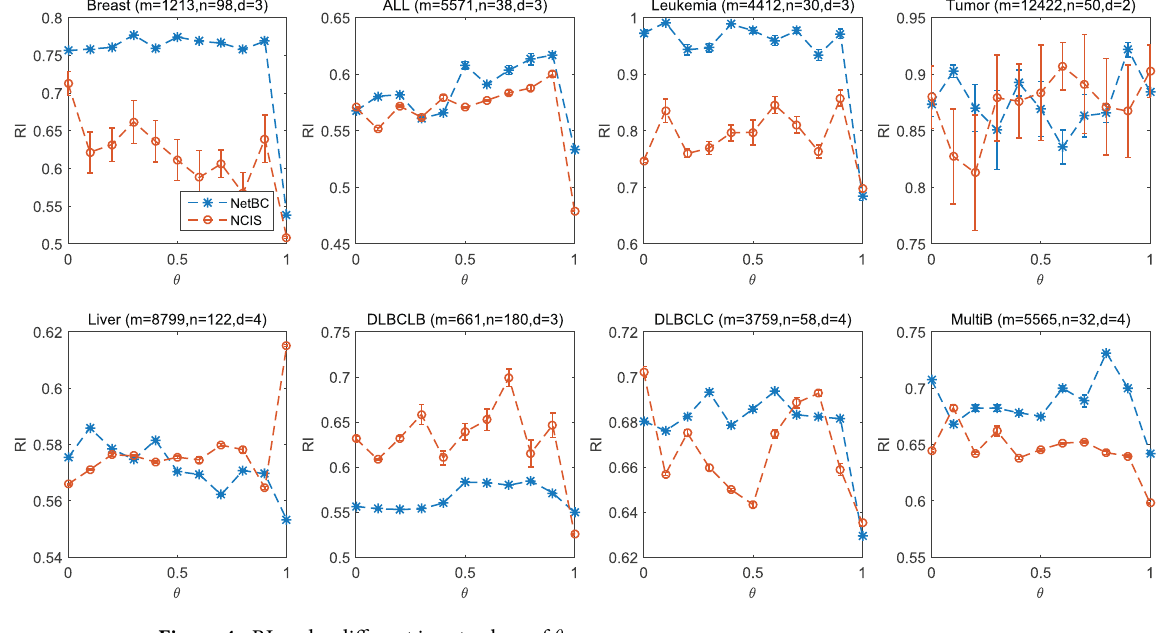
Figure 4. RI under different input values of θ .